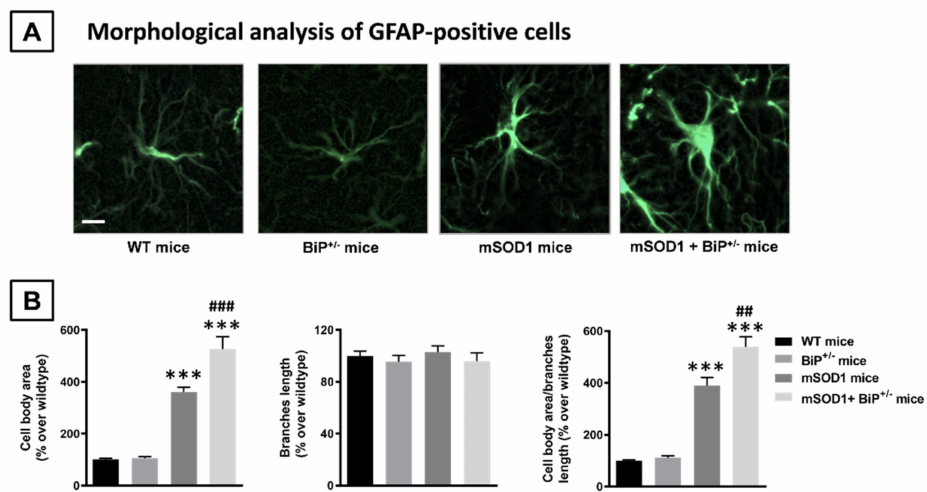
Figure 5. Representative images of GFAP-positive cells (panel ( A ); scale bar = 25 µ m) detected in the spinal cord (lumbar ventral horn) of mSOD1 transgenic and wild-type male mice with normal or partial ablation of the BiP protein, and their morphological analysis (cell body area, length of branches and their ratio; panel ( B )). Values are means ± SEM of 5–7 animals per group. Data were assessed by one-way analysis of variance followed by the Tukey test (*** p < 0.005 vs. WT and BiP +/ − mice; ## p < 0.01, ### p < 0.005 vs. mSOD1